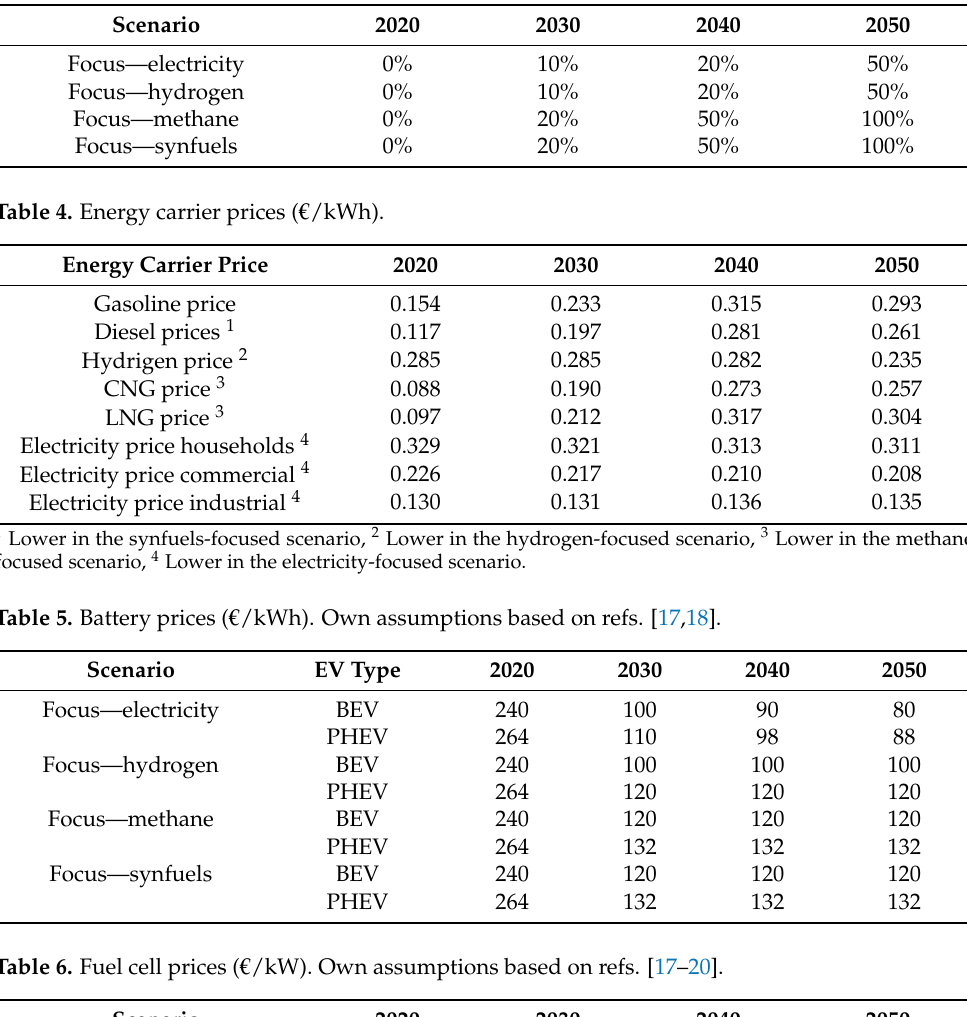
Table 3. Assumed share of synthetic fuels in transport.